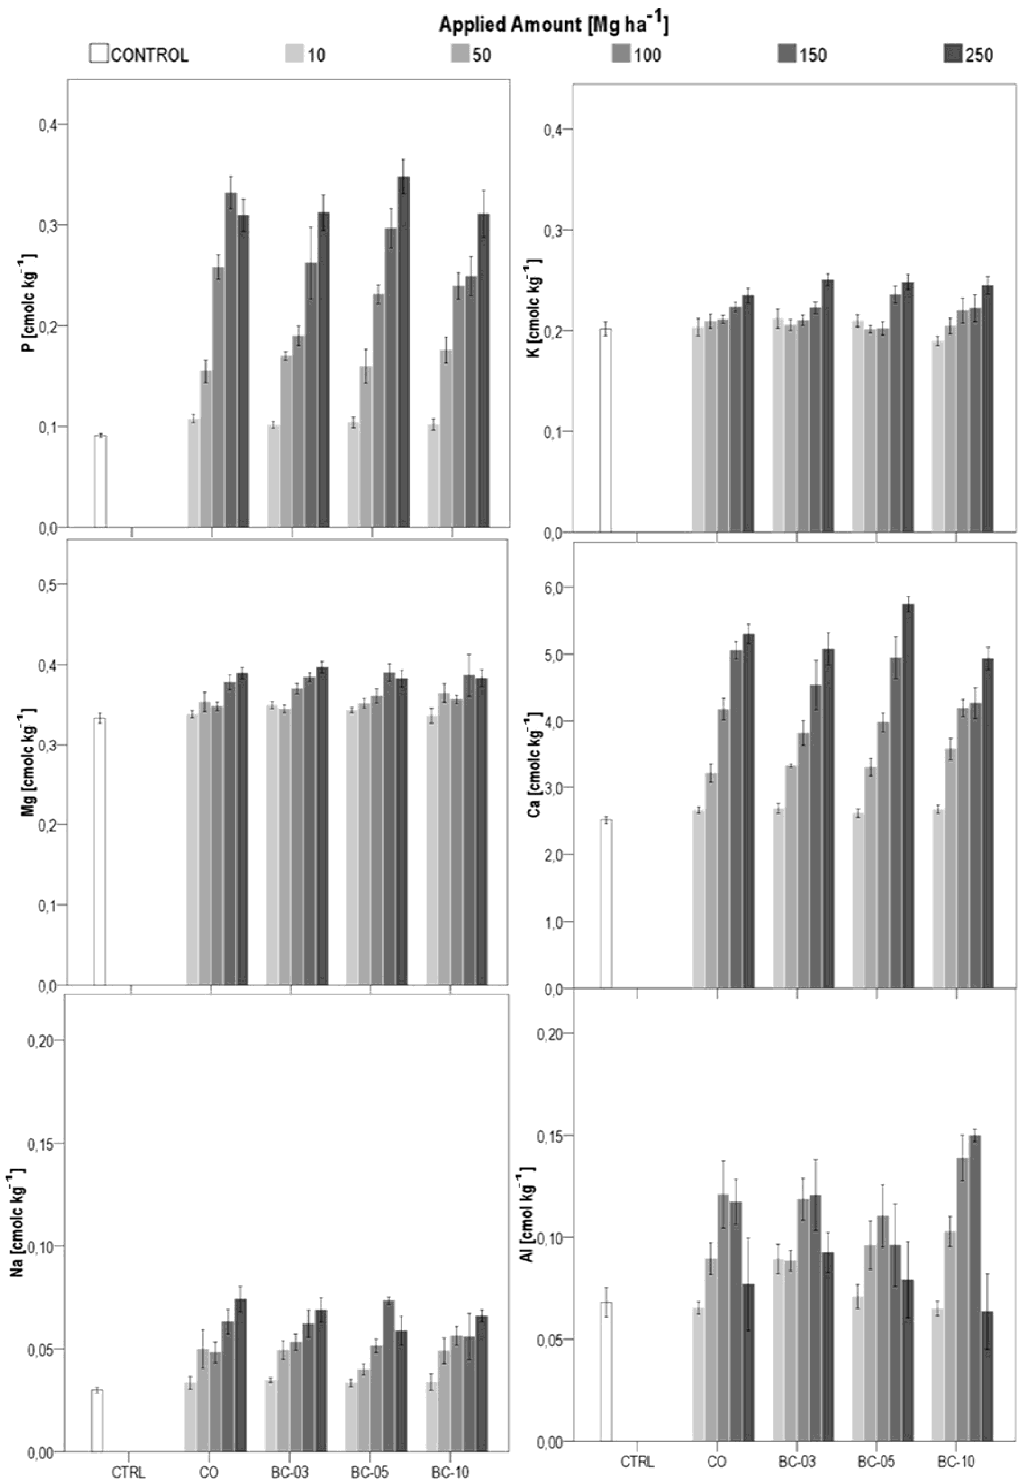
Figure 7. Plant-available nutrients and Aluminum (in cmolc kg −1 soil) on loamy substrate depicted for five treatments (CO = pure compost, BC-03 = compost with 3 kg Mg −1 w / w biochar, BC-05 = compost with 5 kg Mg −1 w / w biochar, BC-10 = compost with 10 kg Mg −1 w / w biochar) in five application amounts (10, 50, 100, 150, 250 Mg ha −1 ) versus control (CTRL = pure loamy substrate) ( n =